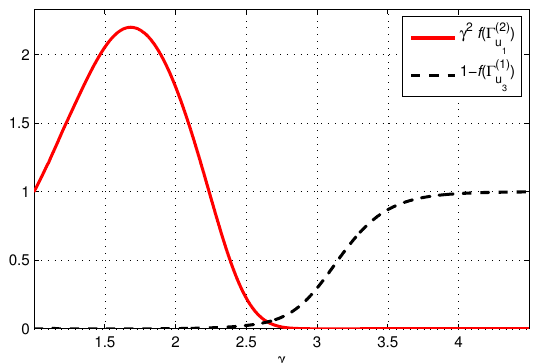
(cid:16) (cid:17) (cid:16) (cid:17) Γ ( 1 ) Γ ( 2 ) γ 2 as functions of γ , for and f u 3 , m u 1 , m